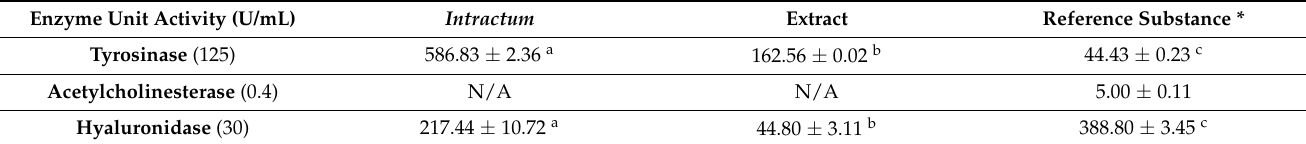
Table 3. The anti-enzymatic activity of the intractum and extract. The results are presented as the IC 50 value [ µ g/mL]. * Kojic acid was used as a reference substance in tyrosinase assay, physostigmine in acetylcholinesterase assay and aescin in hyaluronidase assay. Different superscript letters within the same row indicate statistically significant differences with p <